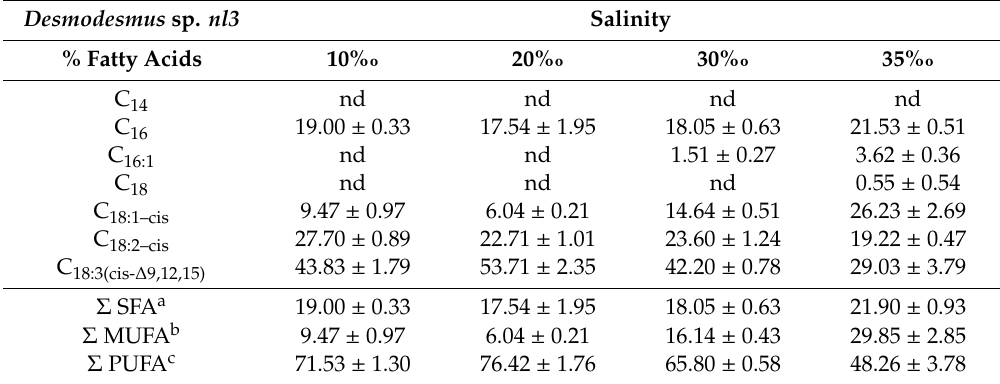
Table 5. Fatty acid profiles of Desmodesmus sp. nl3 in di ff erent salinities (n = 3) harvested in stationary phase. Desmodesmus sp. nl3